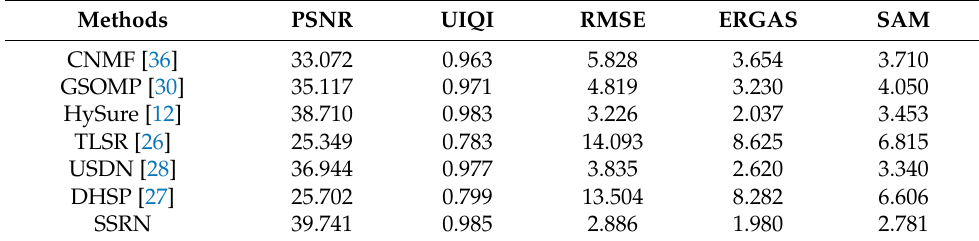
Table 5. Quantitative experimental results on the Pavia University (PU)